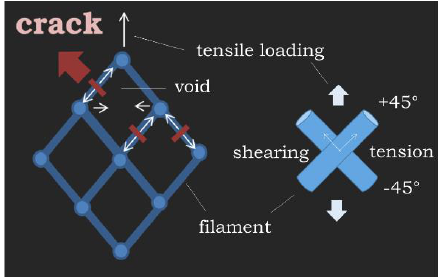
Figure 9. Stress transfer in 3D-printed PLA highlighting qualitative explanation of the difference between tensile properties of as-received and printed PLA.